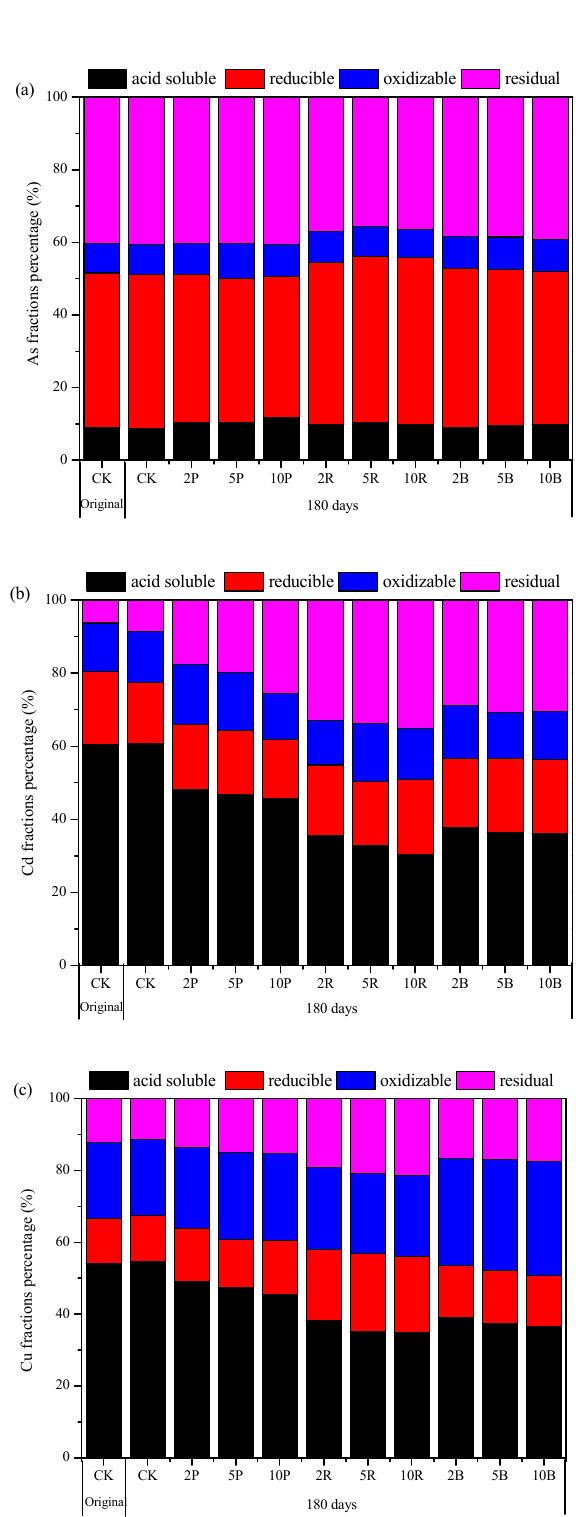
Figure 2. Proportions of different As ( a ), Cd ( b ), and Cu ( c ) fractions after 180 days of incubation (CK: control; 2P: 2% phosphate; 5P: 5% phosphate; 10P: 10% phosphate; 2R: 2% red mud; 5R: 5% red mud; 10R: 10% red mud; 2B: 2% biochar; 5B: 5% biochar; 10B: 10% biochar). 3.3. Effects of Three Amendments on Phytoavailability of Soil As, Cd, and Cu The concentration of NH 4 H 2 PO 4 − extractable As (NH 4 H 2 PO 4 − As) increased initially, reached a peak on day 10, then decreased after that. Compared to the control, adding